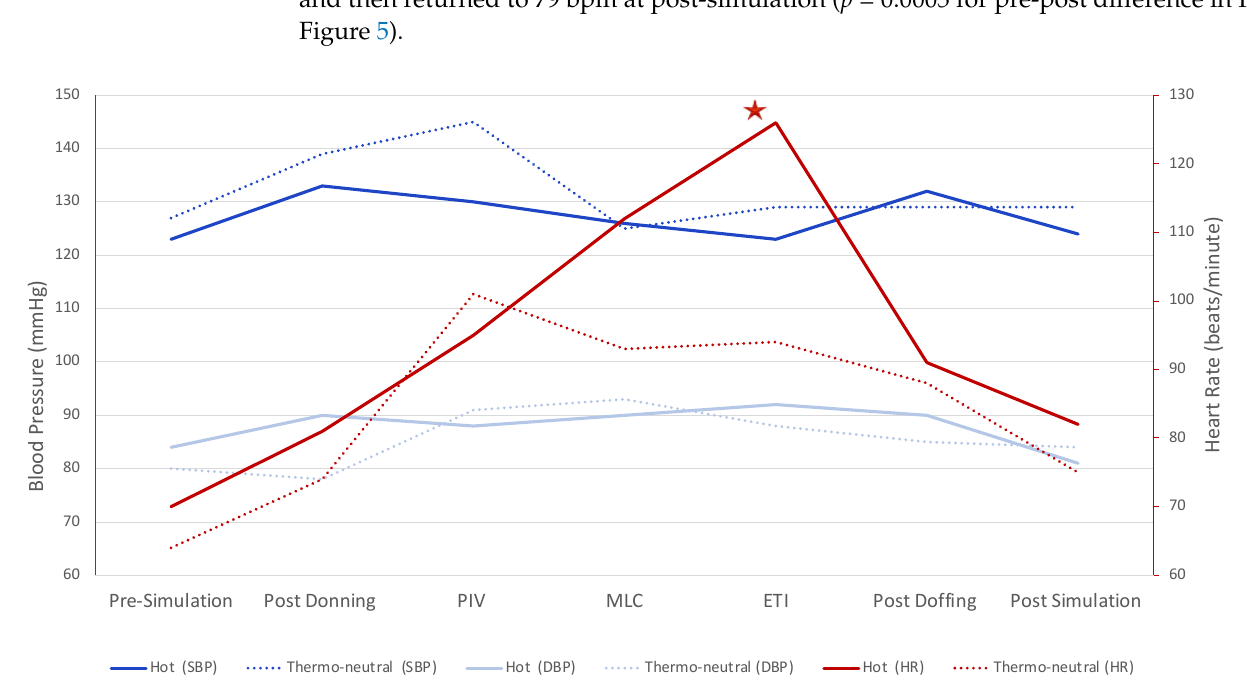
Figure 5. Changes in medians of systolic blood pressure (SBP), diastolic blood pressure (DBP), and heart rate (HR) in both hot (solid lines) and thermo-neutral (dotted lines) conditions at seven time points throughout the simulation. Tasks included peripheral intravenous catheter insertion (PIV), midline catheter insertion (MLC), and endotracheal intubation (ETI). The only significant difference in vital signs between hot and thermo-neutral conditions was for HR during endotracheal intubation, denoted by the star ( p = 0.029).